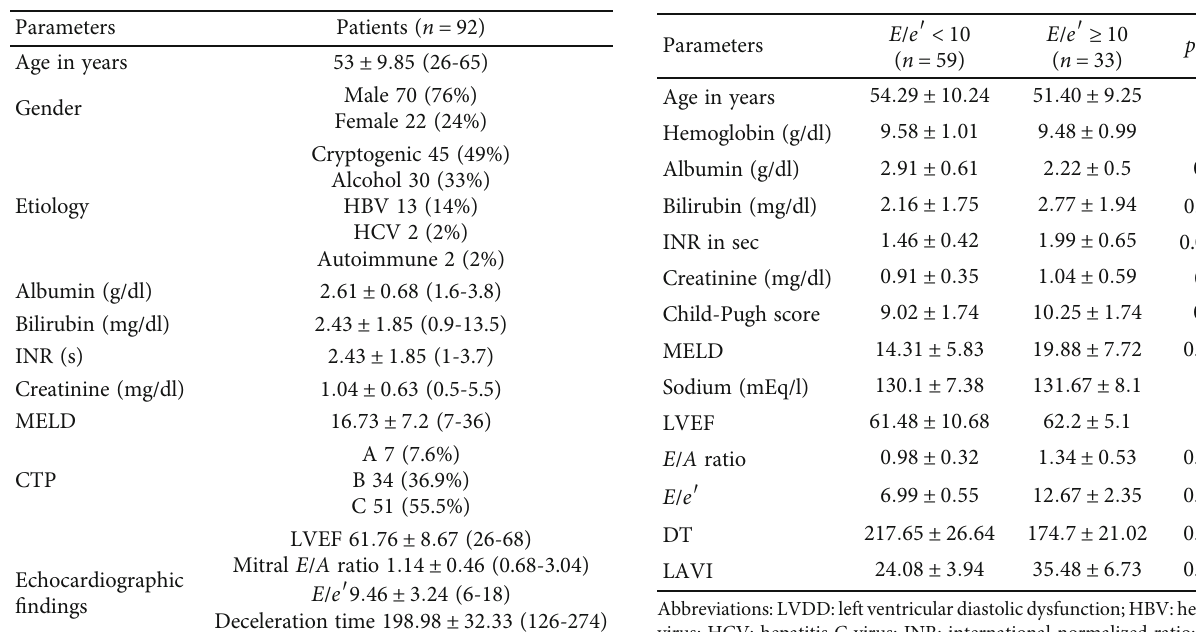
Table 1: Demographic, clinical and echocardiographic data of decompensated cirrhotic patients enrolled in the